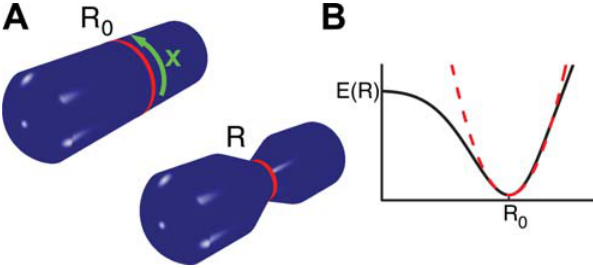
Figure 2. Illustration of key quantities used in the theoretical analysis. (A) Schematic representation of a cylindrical cell with a contractile ring of initial radius R 0 (left) and contracted state with radius R , R 0 (right). The position along the ring is denoted by x . (B) Schematic representation of the elastic energy E(R) as a function of ring radius (black). The dashed red line represents the approximation to E(R) given by Eq. (1), which we used in our calculations.